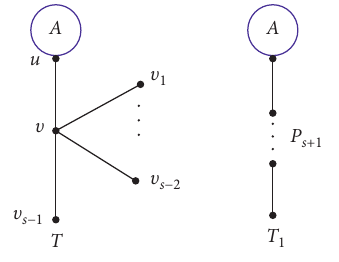
Figure 1: The trees T and T